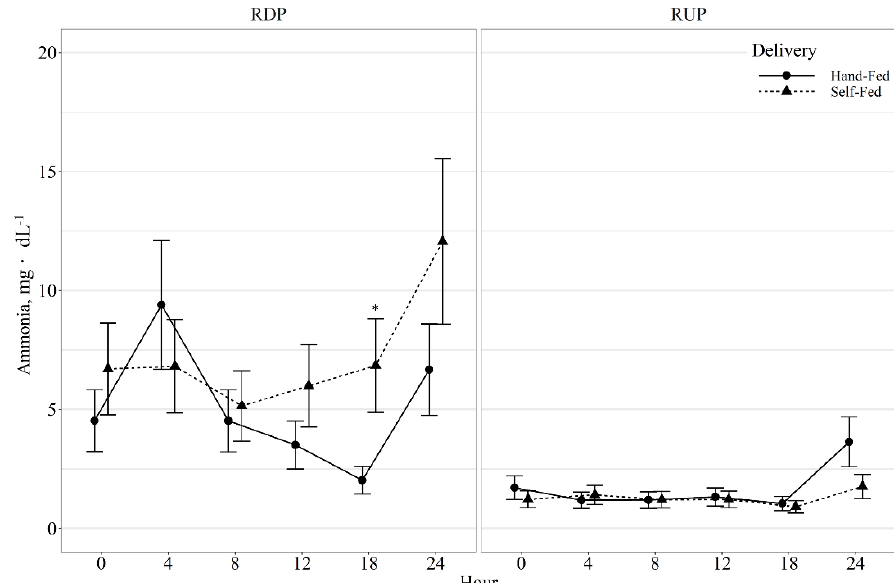
Figure 1. Ruminal ammonia concentrations of beef cows fed hand-fed or self-fed rumen degradable (RDP) or rumen undegradable (RUP) protein supplements with low-quality forage at 08:00. Ruminal ammonia concentrations were influenced by delivery method × protein type × hour post-feeding interaction ( p < 0.01), and differences within hour post-feeding are denoted by *, timepoints without a common letter are different ( p < 0.05).